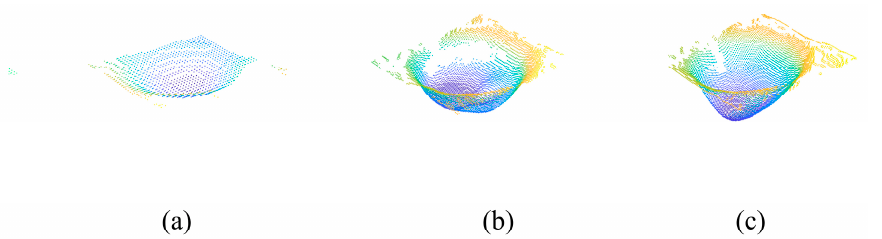
Figure 9. Simulated Concrete Disease Point Cloud. ( a ) No. 1 simulated concrete disease. ( b ) No. 2 simulated concrete disease. ( c ) No. 3 simulated concrete disease.